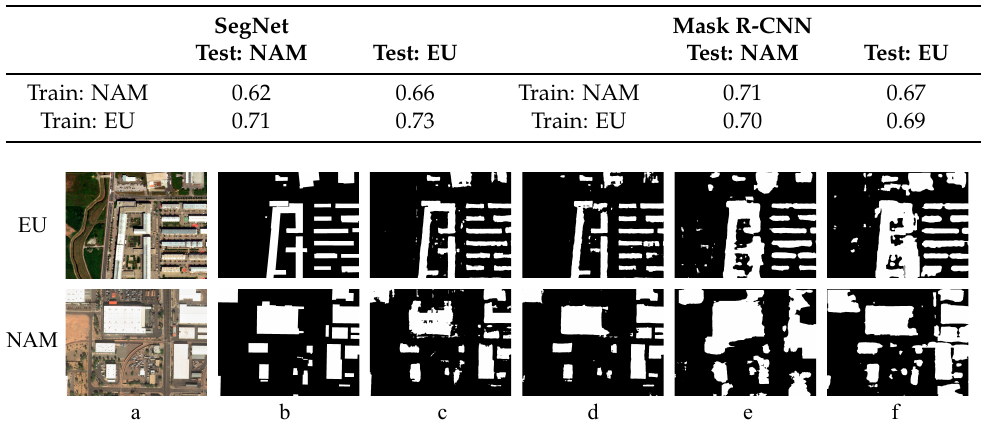
Figure 10. Generalization across continents (RQ4): two images from the test sets from Europe (EU) and North America (NAM) together with the predicted masks by our models: ( a ) input image; ( b ) ground truth; ( c ) SegNet trained on EU; ( d ) SegNet trained on NAM; ( e ) Mask R-CNN trained on EU; ( f ) Mask R-CNN trained on